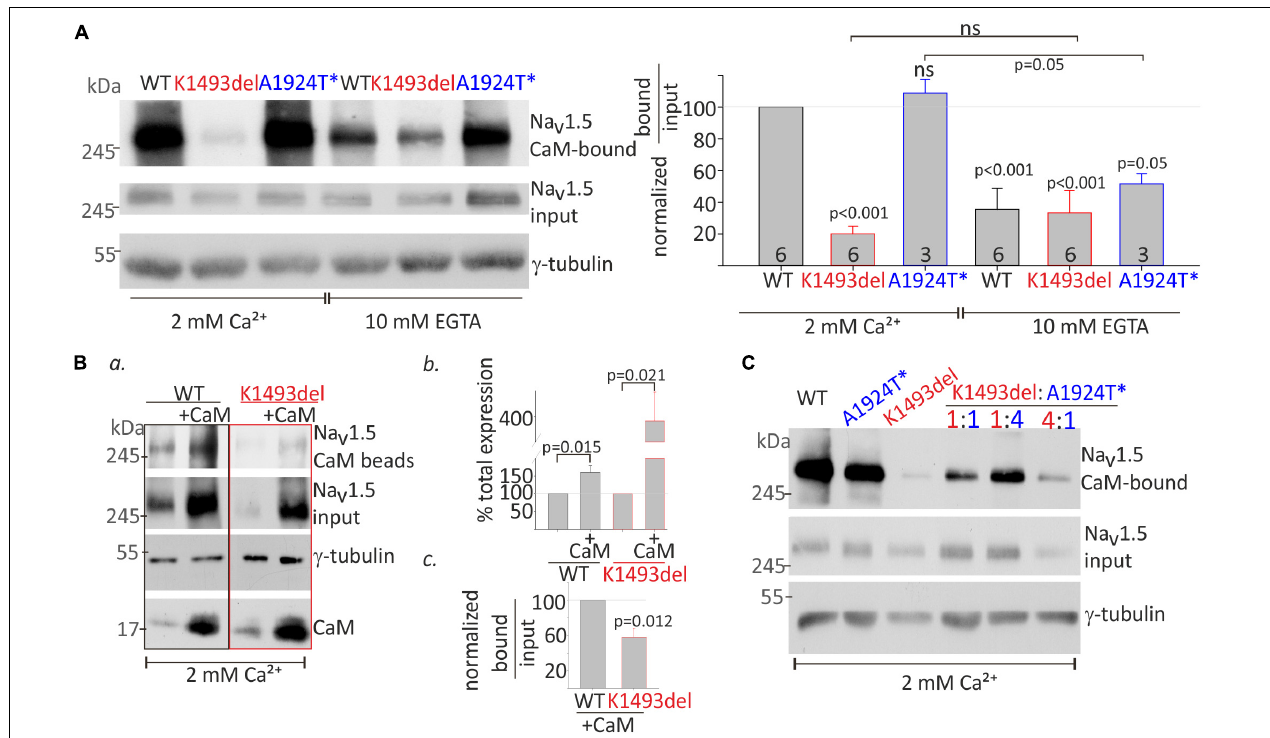
FIGURE 5 | CaM-interaction with Na V 1.5 variants (A) . HEK cells were transfected with Na V 1.5 WT , Na V 1.5 K1493del , and Na V 1.5 A1924T ∗ together with rNa V β 1. Lysates from transfected groups were pulled-down with CaM-agarose beads in Ca 2 + and EGTA. Left, a representative Western blot from a pull-down assay. Right, the CaM-bound fraction was normalized to input level, and presented as % of Na V 1.5 WT in 2 mM Ca 2 + , in the same experiment. Statistical significance was determined by one-way ANOVA followed by Holm–Sidak test. P -value compared to Na V 1.5 WT in 2 mM Ca 2 + is indicated above each bar. (B) Na V 1.5 WT and Na V 1.5 K1493del with or without co-expressed CaM were pulled-down with CaM-agarose beads in 2 mM Ca 2 + . (a) CaM- bound Na V 1.5, and total input levels of Na V 1.5, CaM and γ -tubulin were detected in Western-blot. (b) Input Na V 1.5+CaM levels were normalized to Na V 1.5 without CaM, from the same experiment, N = 4. (c) CaM-bound fractions were normalized to input levels, and are presented as % of Na V 1.5 WT +CaM in the same experiment, N = 3. Statistical significance was estimated by t -test. (C) HEK cells transfected with equal total Na V 1.5 α -subunit (7.5 µ g; ratio 1:1, 3.75 µ g of each construct; ratio 1:4, 1.5, and 6 µ g of the constructs indicated) together with rNa V β 1. Lysates from transfected groups were pulled-down with CaM-agarose beads in 2 mM Ca 2 + . This is a representative experiment out of